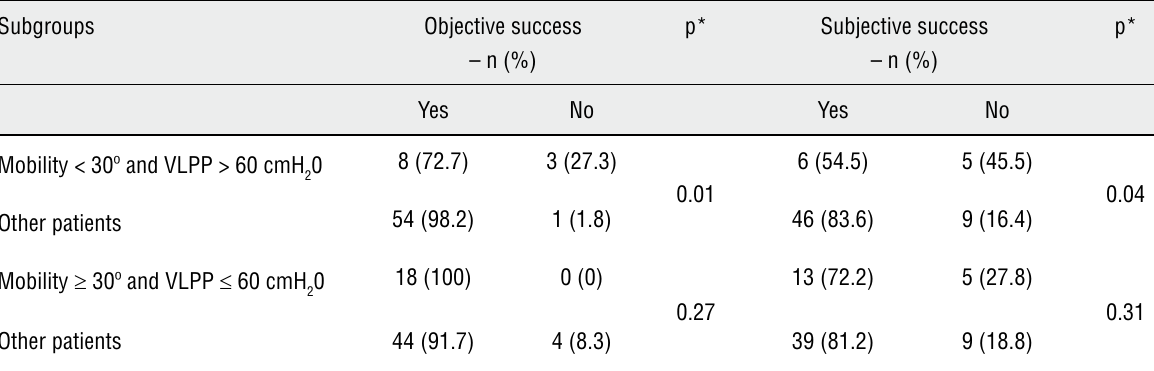
Table 4 - Subgroups compared to the remaining of the studied population.